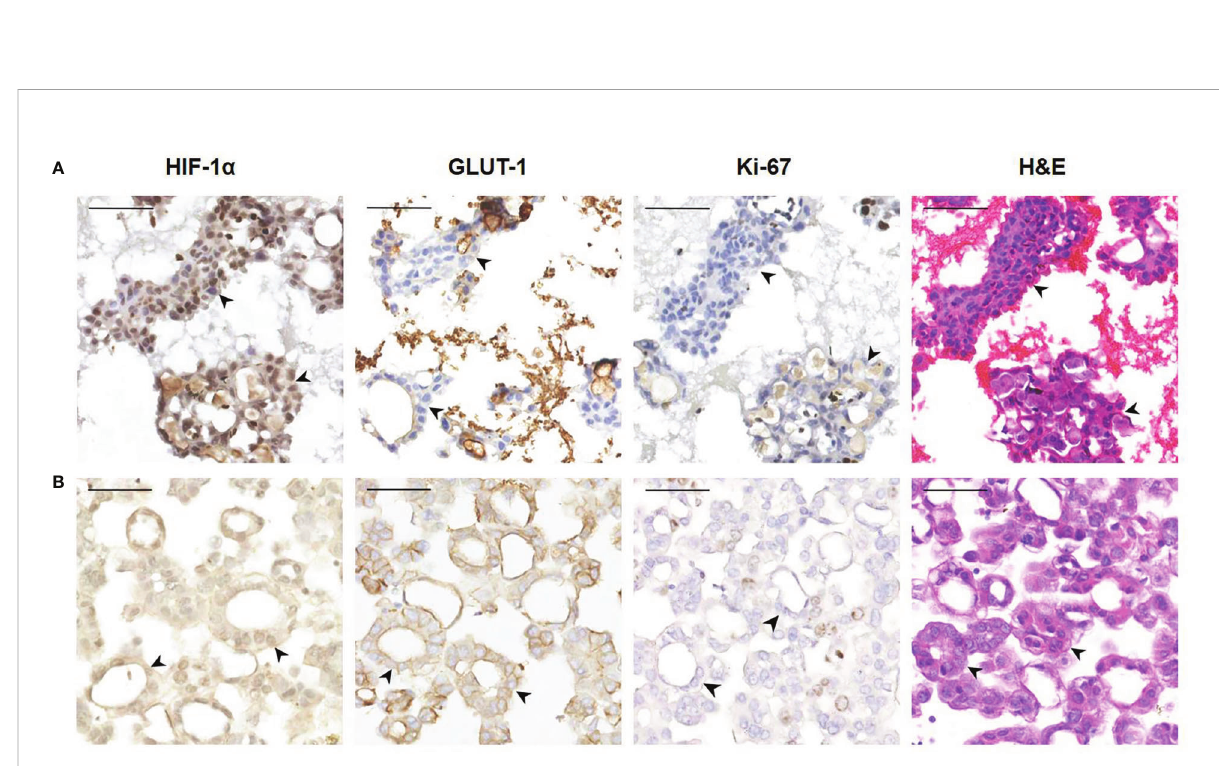
FIGURE 6 Representative images showing HIF-1 a , GLUT-1 and Ki-67 expression of human tumor cells in pleural effusion. (A) A 63-year-old female was diagnosed with adenocarcinoma of the lung. The black arrowheads show clusters of tumor cells in pleural effusion (400×). These tumor cells are HIF-1a positive and GLUT-1 negative with a low Ki-67 index. Bar , 50 m m. (B) A 72-year-old female was diagnosed with breast carcinoma. The black arrowheads show a glandular arrangement of tumor cells in pleural effusion (400×). These tumor cells are HIF-1a positive and GLUT-1 positive with a low Ki-67 index. Bar , 50 m